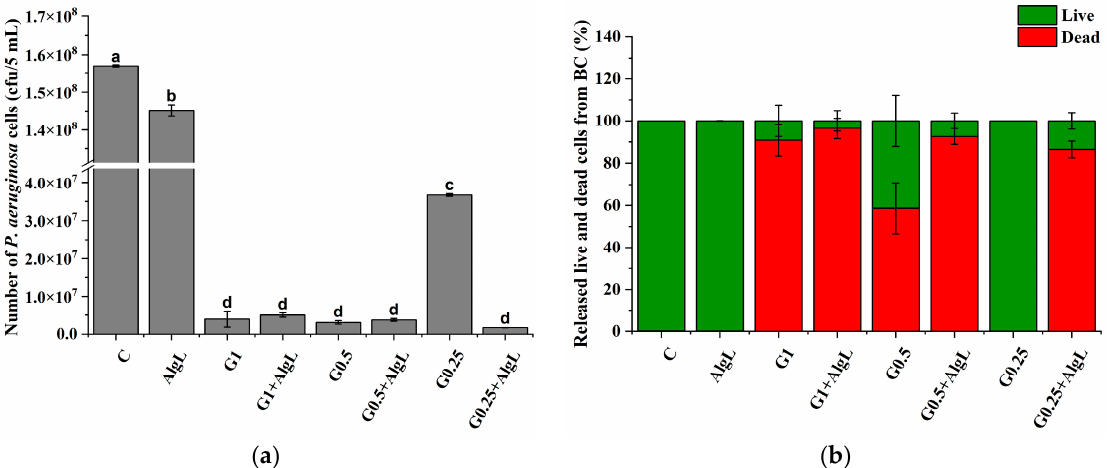
Figure 12. Amount of the P. aeruginosa PAO ‐ 1 cells ( a ) and the percentage of the live and dead cells of P. aeruginosa PAO ‐ 1 ( b ) released from BC with immobilised AlgL (0.2 mg/mL) and gentamicin cells of P. aeruginosa PAO-1 ( b ) released from BC with immobilised AlgL (0.2 mg/mL) and (0.25–1 μ g/mL) ( b ). The means with the same superscript (a–d) are not significantly different, with gentamicin (0.25–1 µ g/mL) ( b ). The means with the same superscript (a–d) are not significantly p > 0.05. Error bars represent standard deviation. different, with p > 0.05. Error bars represent standard